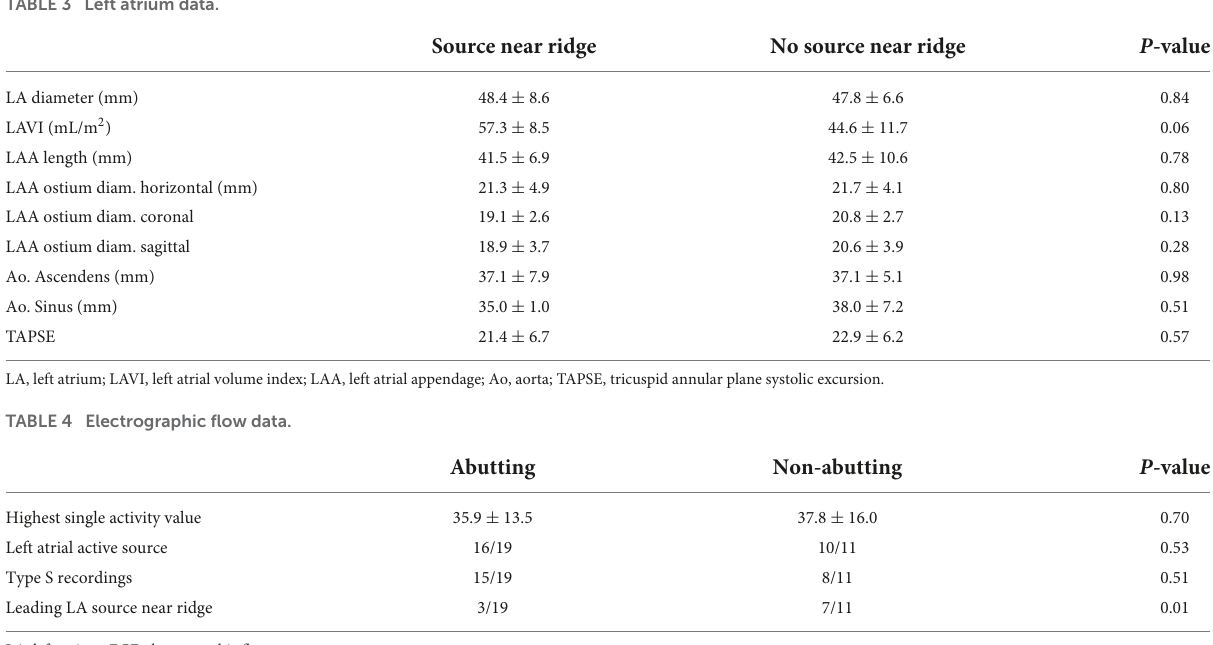
TABLE 3 Left atrium data.